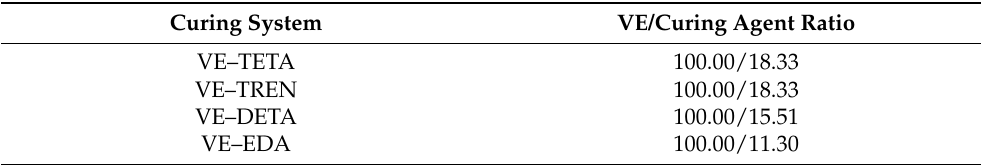
Table 1. Weight ratios of vanillyl alcohol–based epoxy resin to curing agents for different curing